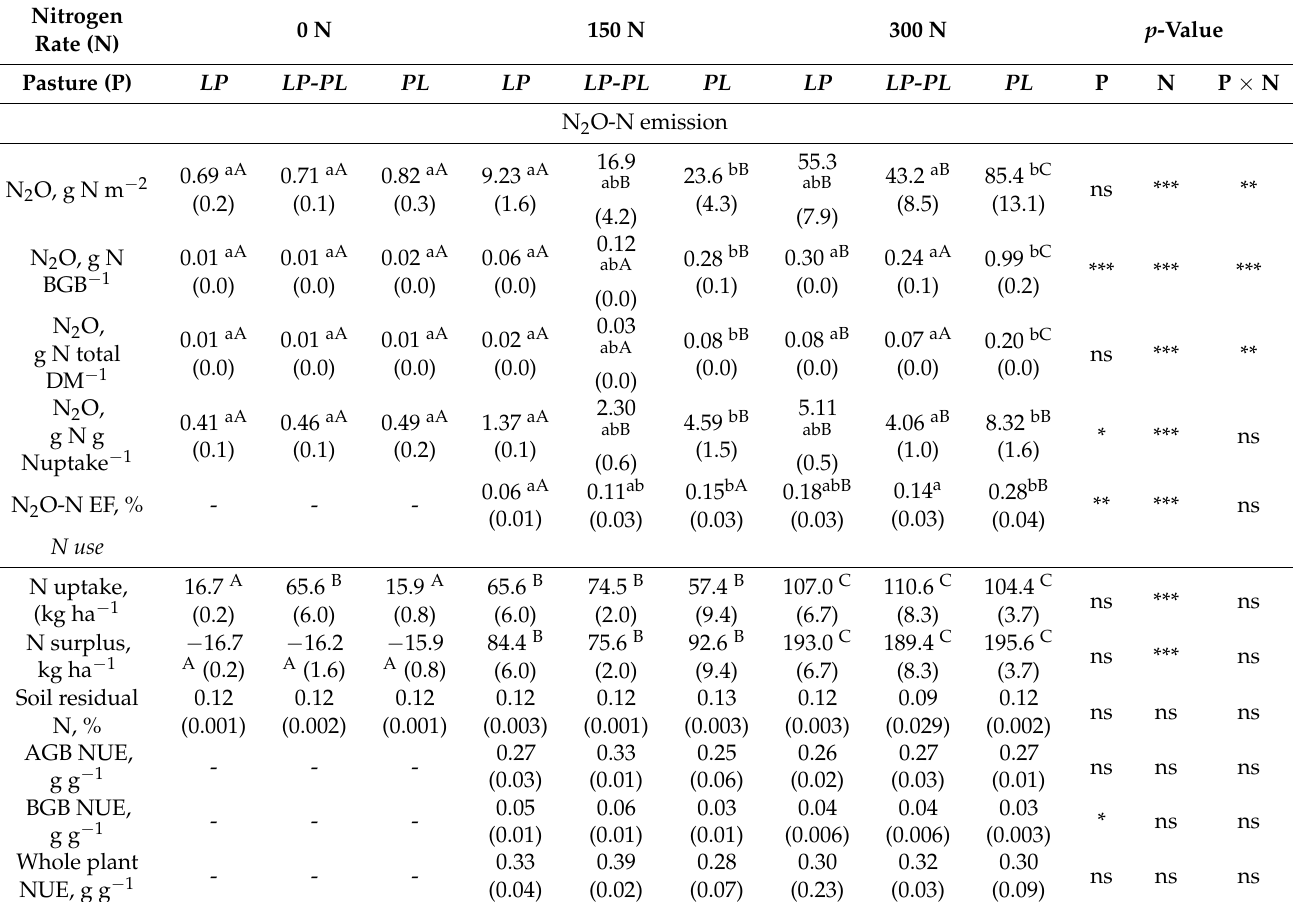
Table 2. Cumulative N 2 O emissions (83 days), as well as N 2 O emissions in relation to above- (AG) and belowground biomass (BG) among the different treatments.